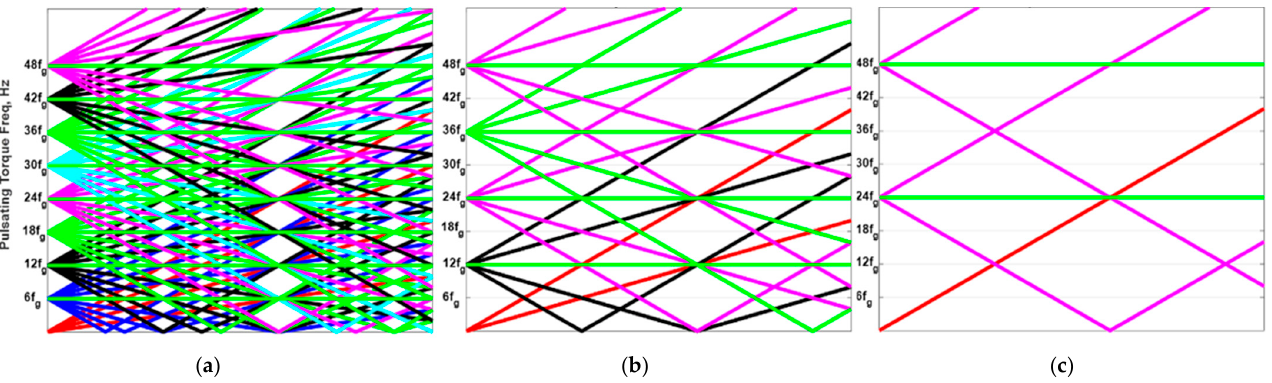
Figure 11. Campbell diagram of air-gap torque harmonics of a synchronous motor fed by ( a ) 6/6-pulse LCI system, ( b ) 12/12-pulse LCI system and ( c ) 24/24-pulse LCI system.